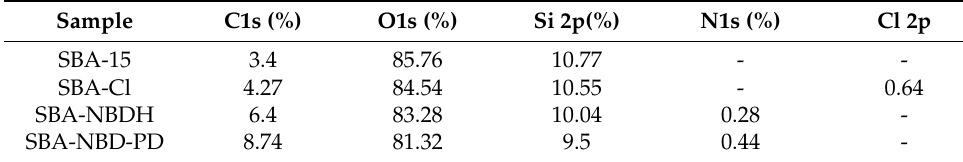
Table 3. Surface composition of SBA functionalized matrix from XPS.